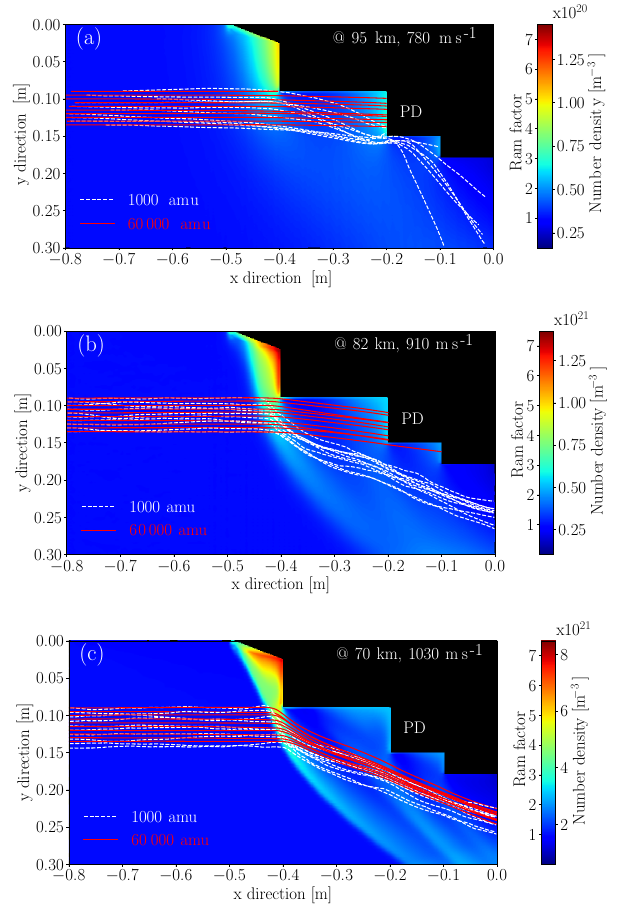
Figure 2. Results of combined DSMC and electrostatic simula- tions for WADIS-2 payload. The black area shows one half of the WADIS-2 front deck. X axis is along the rocket’s roll axis. The po- sition of the particle detector is indicated with PD. Density field derived using the DSMC for 95, 82 and 70km. White and red lines correspond to trajectories of particles with 1000 and 60000amu, respectively. The upstream flow is from left.